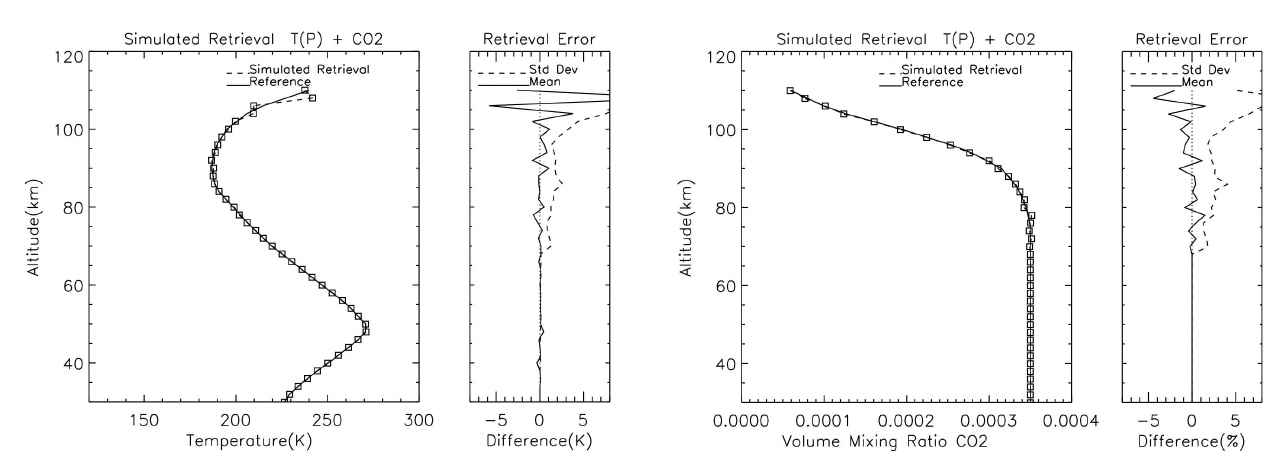
Fig. 21. Temperature profile results from simultaneous T (P) and CO 2 mixing ratio retrieval using 2 channels in the vicinity of 4.3 and 2.7µm with 10 − 5 random noise. Right-hand panel shows the mean error and error standard deviation due to 10 − 5 random measurement error on broadband averaged transmittance.